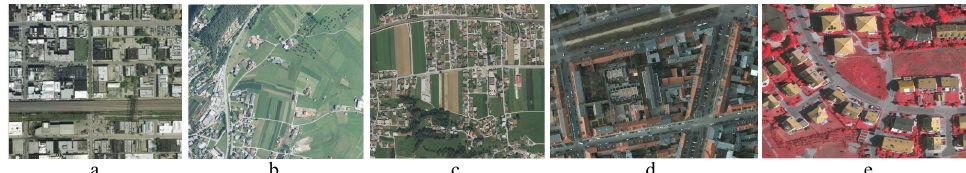
Figure 5. Example images from the INRIA dataset ( a – c ) and from the ISPRS dataset ( d , e